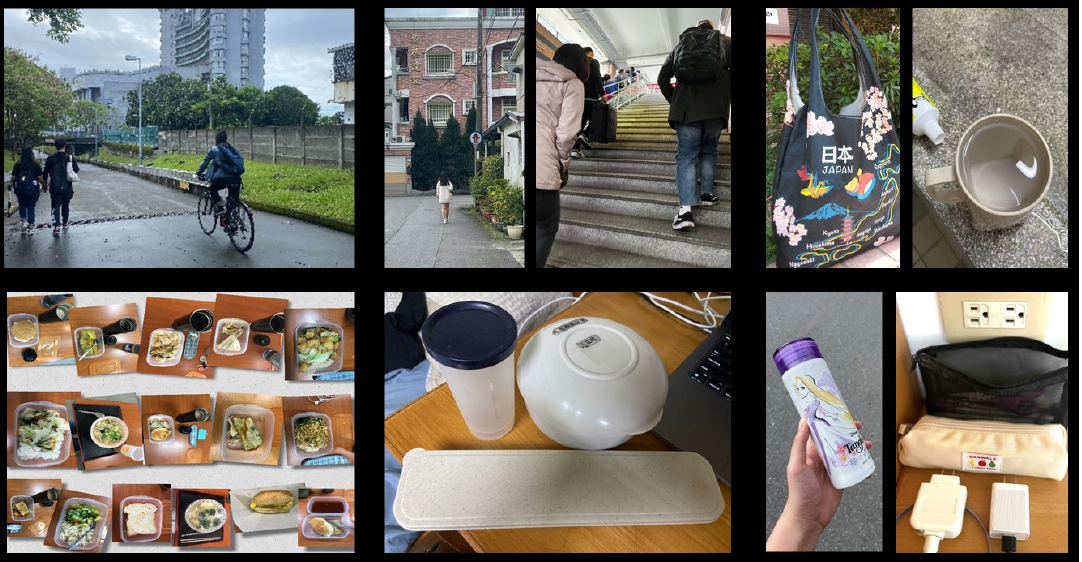
Figure 4. Photos within written thoughts of undergraduates from Experimental Group documenting their environmentally friendly behavior: (clockwise from top left) cycle for distance less than a kilometer or requiring less than 10 min; walk for distance less than a kilometer or requiring less than 10 min; take the stairs instead of the elevator when walking up/down less than three floors; use reusable bags instead of disposable bags; turn off the tap while brushing teeth; switch off electrical appliances when not in use; drink plain water instead of bottled beverages; use reusable instead of disposable eating utensils; eat plant-based diet instead of meat- and plant-based diet.